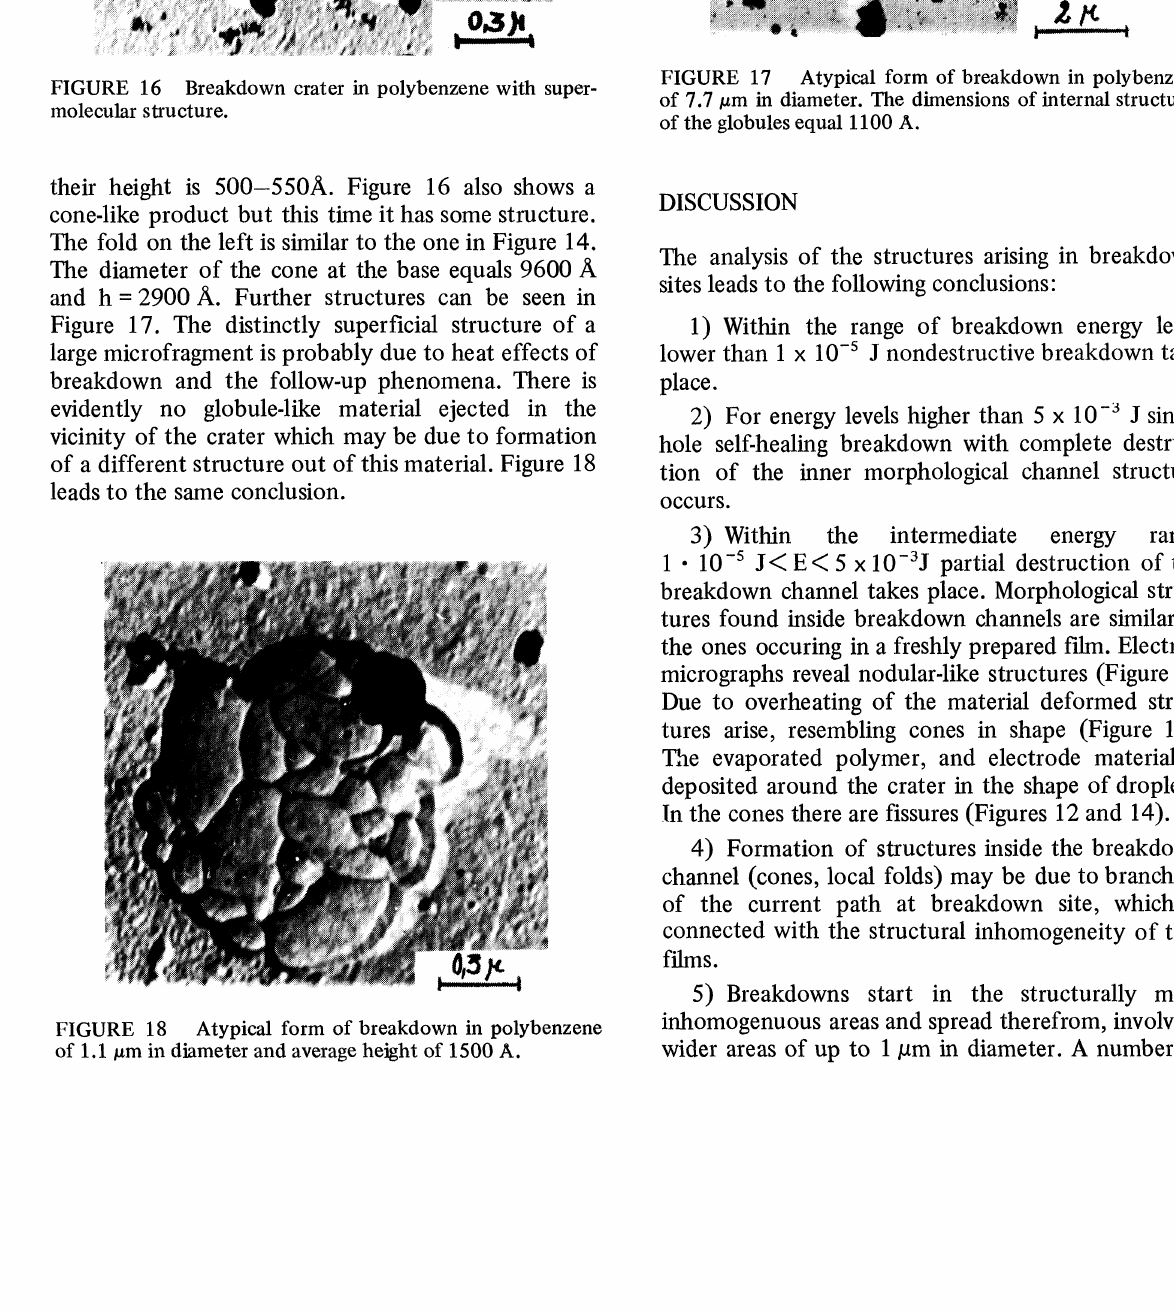
FIGURE 16 Breakdown crater in polybenzene with super- molecular structure.